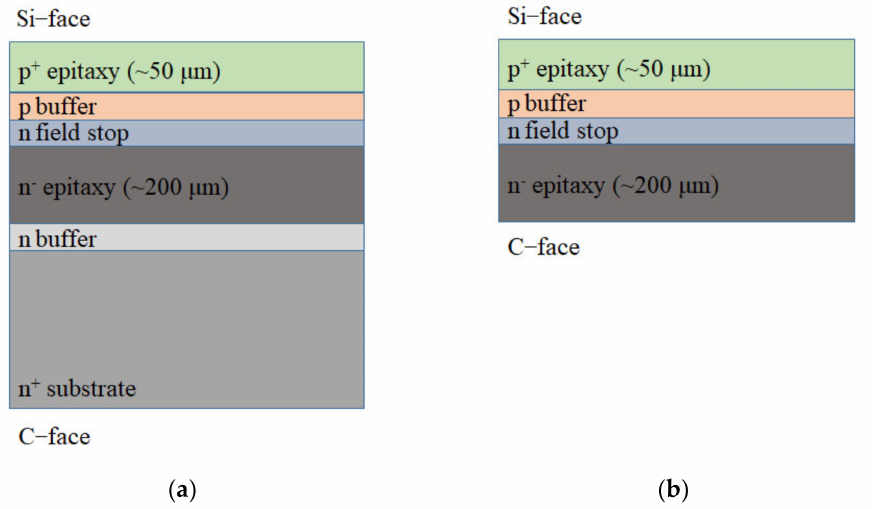
Figure 1. Process flow of the thick multi-layer SiC for the C-face n -channel IGBT: ( a ) growth of epitaxy layer on SiC substrate; ( b ) free-standing